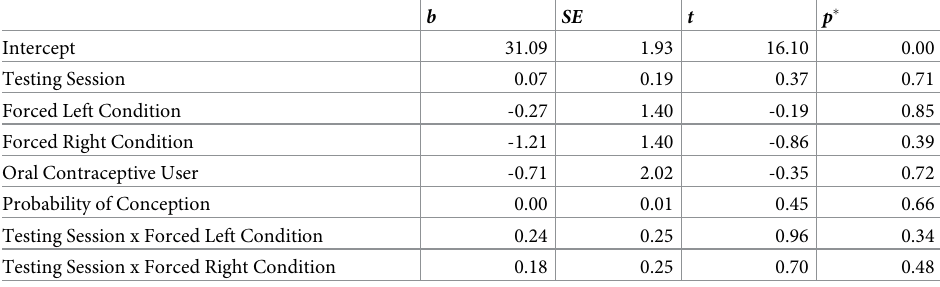
Table 3. Parameter estimates from the mixed-effects model for left ear responses.